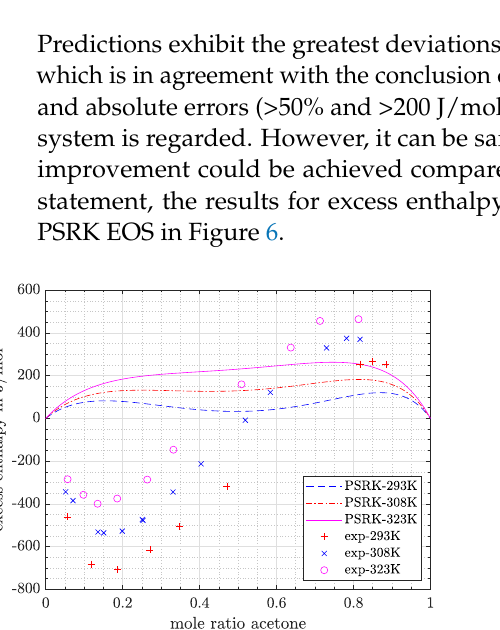
Figure 6. Prediction of excess enthalpy for the acetone/water system using PSRK